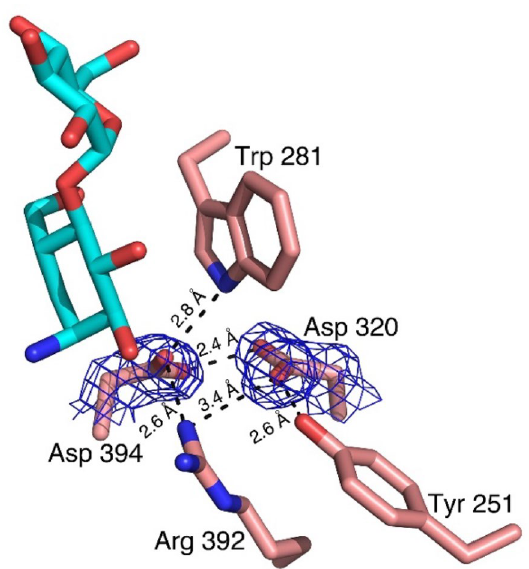
Figure 6. Interactions formed by shifted Asp 394 in Sco GlgE1-V279S/ 7 , the composite 2F O − F C omit map was contoured at 1.5σ.